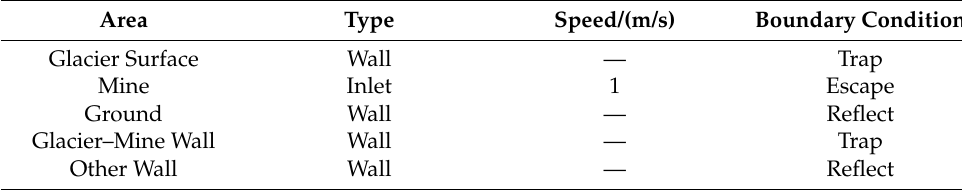
Table 4. Boundary condition parameter settings after adding discrete phase.